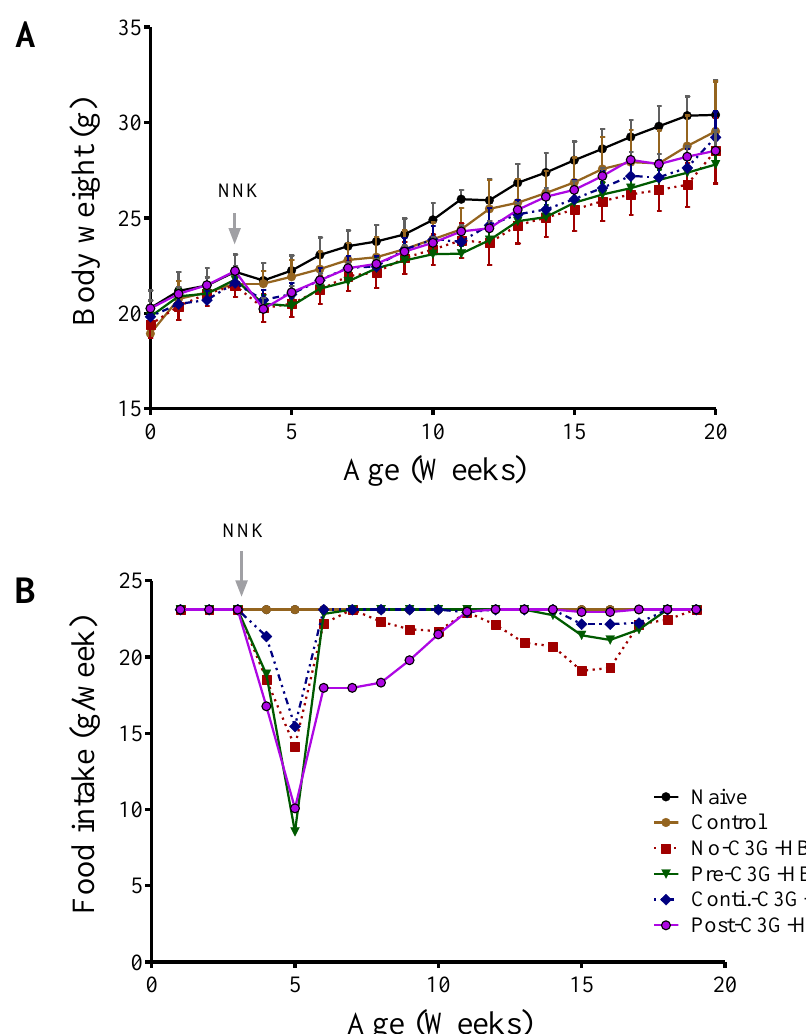
Figure 1. The effect of cyanidin-3- O -glucoside (C3G)-HB and 4-(methylnitrosamino)-1-(3-pyridyl)-1-butanone (NNK) injection on the body weight of A / JCr mice. Naive mice ( n = 5) and NNK-injected mice in group no-C3G-HB (n = 10) were fed a regular mouse diet. Mice in the control (n = 5) and NNK-